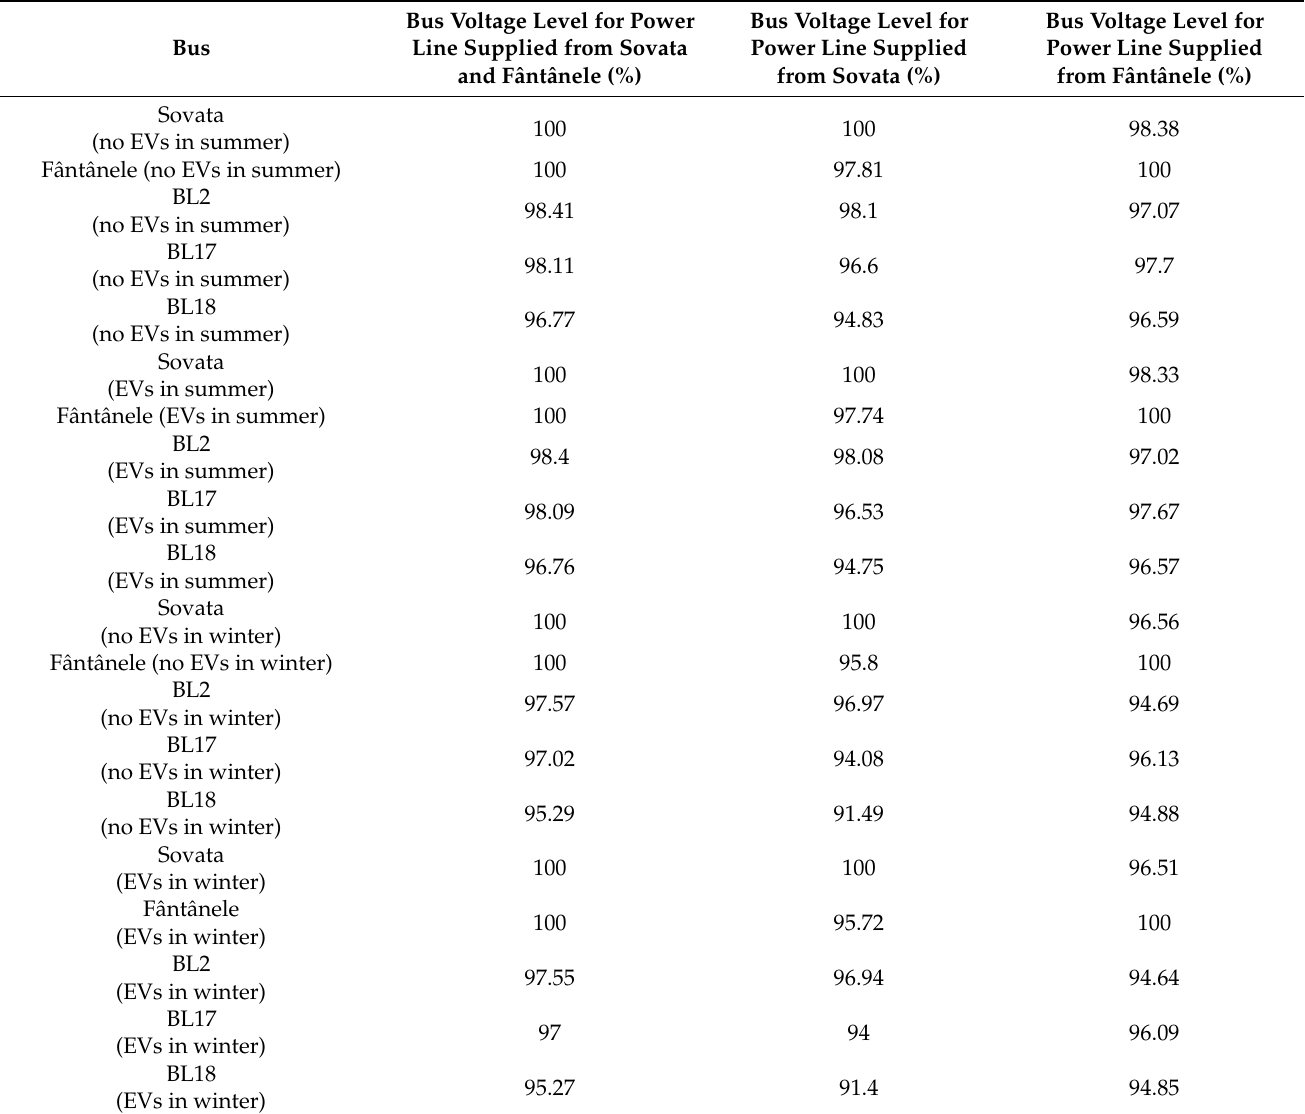
Table 27. Voltage level at 16:00 (scenario 5).